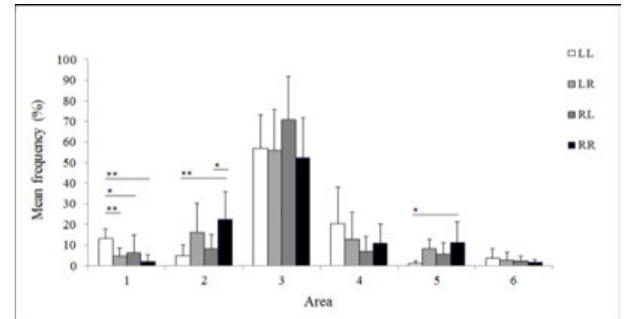
Figure 2. Mean and standard deviations (represented by vertical bars) frequencies for area of ball bouncing in the four examined handedness combinations.